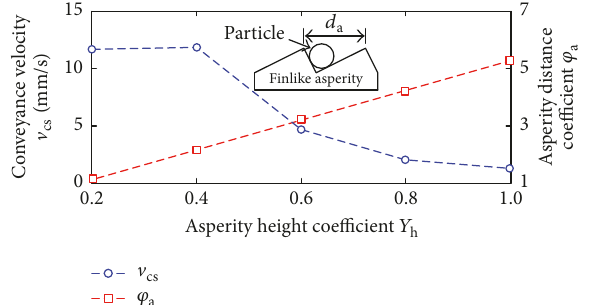
Figure 16: The influence of the finlike asperity height on the particle conveyance velocity and the distance between two asperities ( 𝑌 a = 0.2 and 𝑌 b =